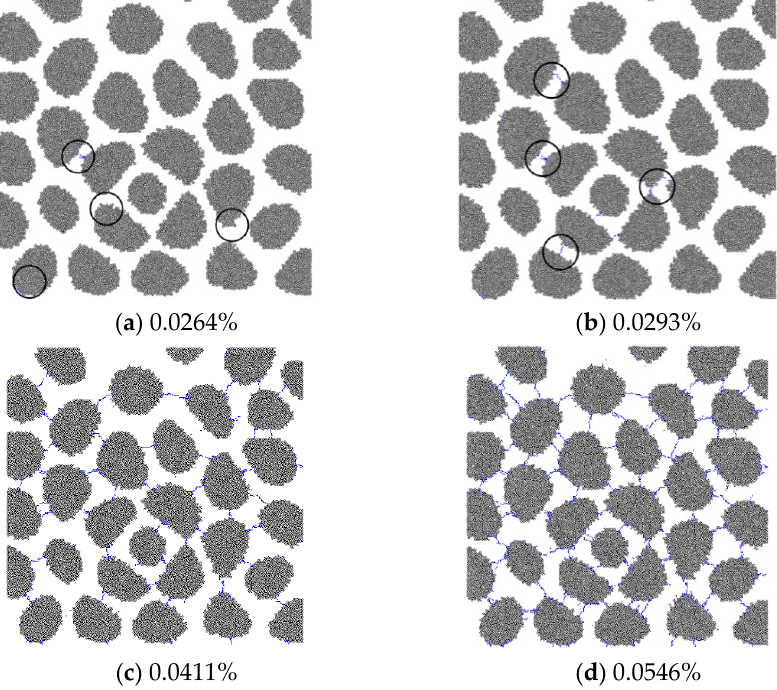
Figure 3. AAR-induced microcracks in RC20-1 as AAR expands.